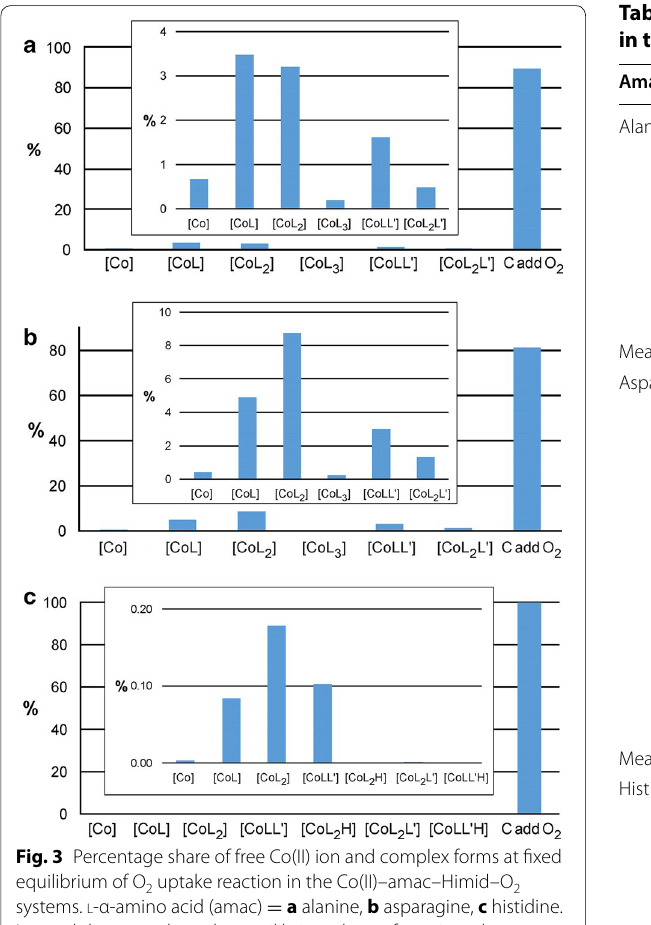
Fig. 3 Percentage share of free Co(II) ion and complex forms at fixed equilibrium of O 2 uptake reaction in the Co(II)–amac–Himid–O 2 systems. l -α-amino acid (amac) a alanine, b asparagine, c histidine. = Internal diagrams show the equilibrium share of species other than the O 2 adduct in an extended scale. C add O 2 denotes the total concentration of the dioxygen adduct(with dioxygen bound both